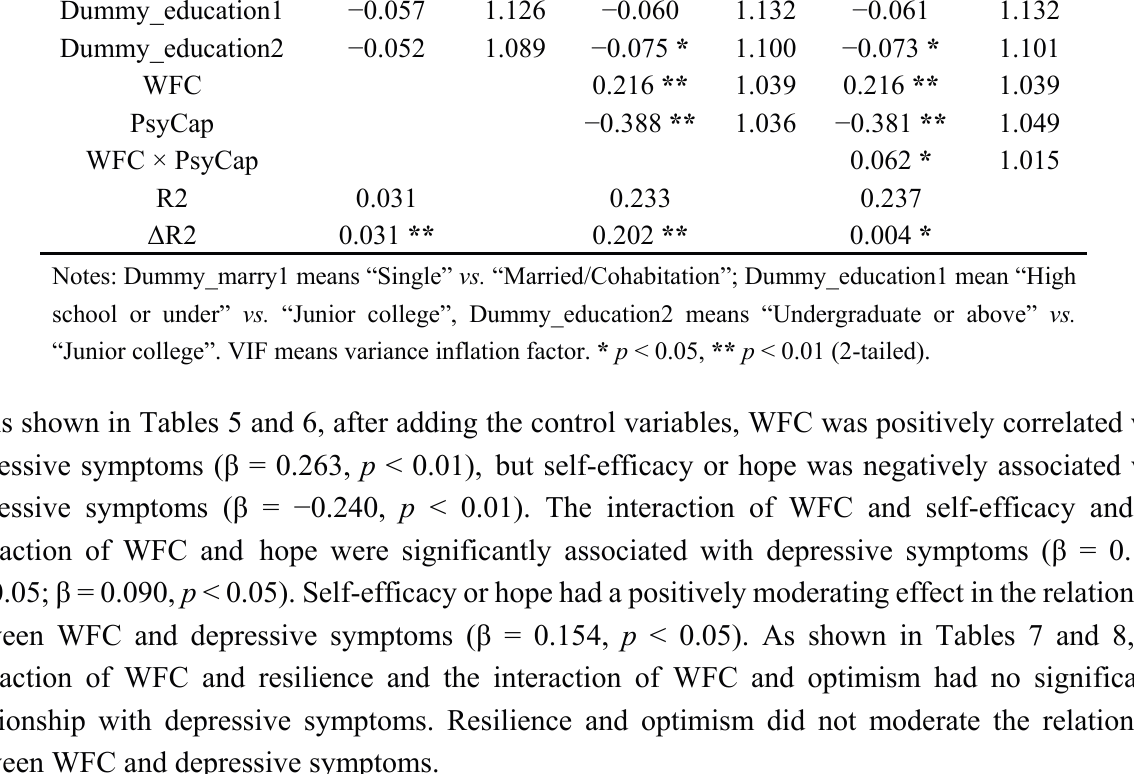
Table 5. WFC as the independent variable and self-efficacy as the moderator in the regression analysis.